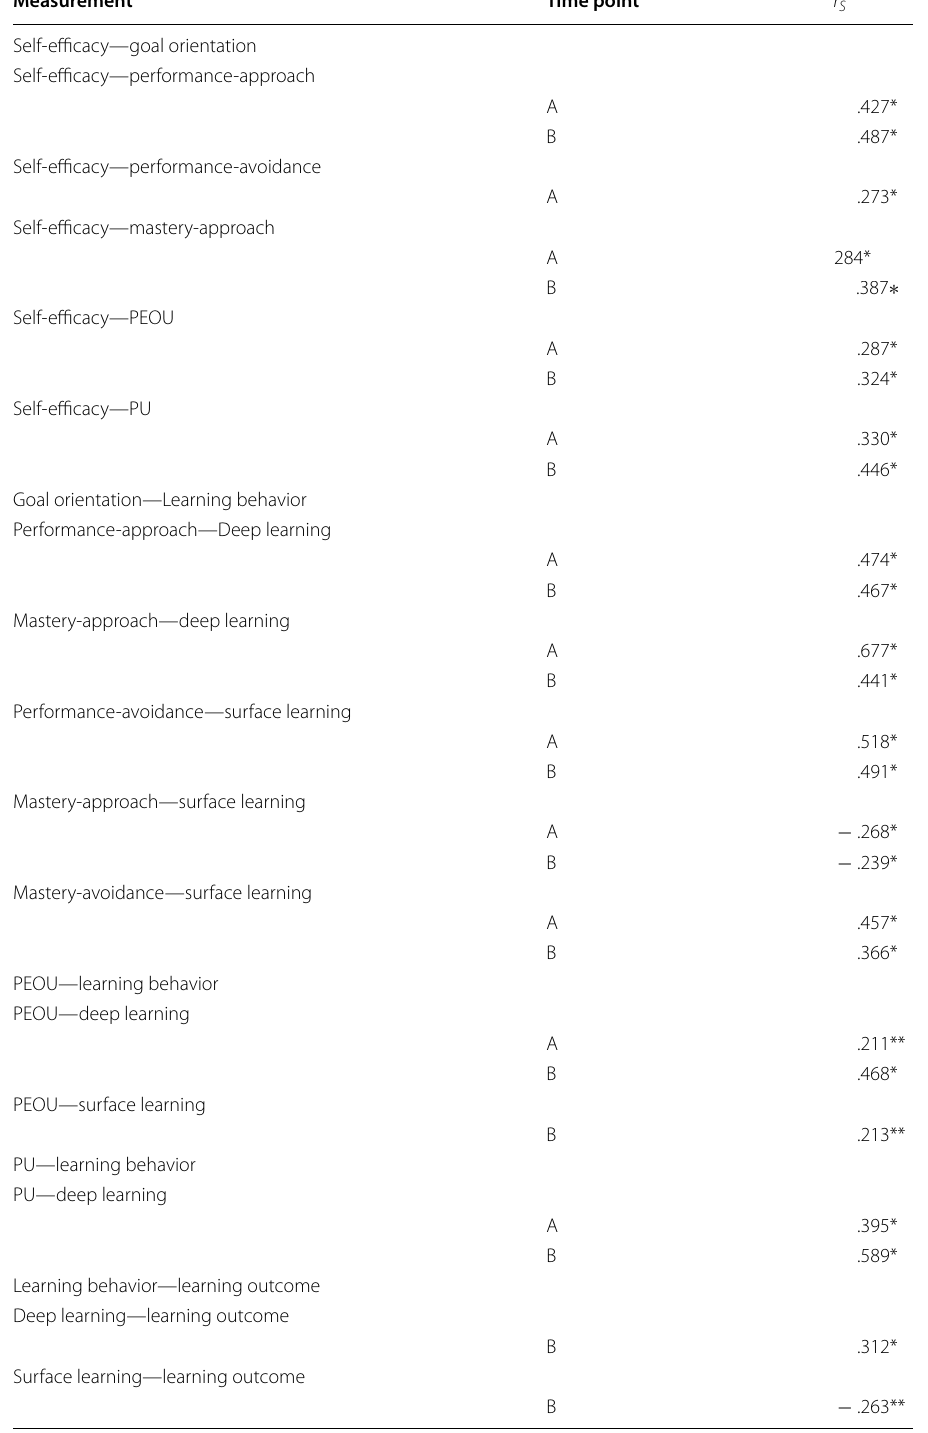
*Correlation is significant at the 0.01 level (2‑tailed) **Correlation is significant at the 0.05 level (2‑tailed)